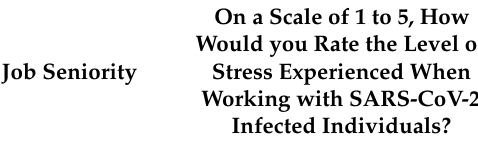
Table 5. Influence of sociodemographic data and perceived stress levels on MBI and WHOQOL-BREF quality of life burnout